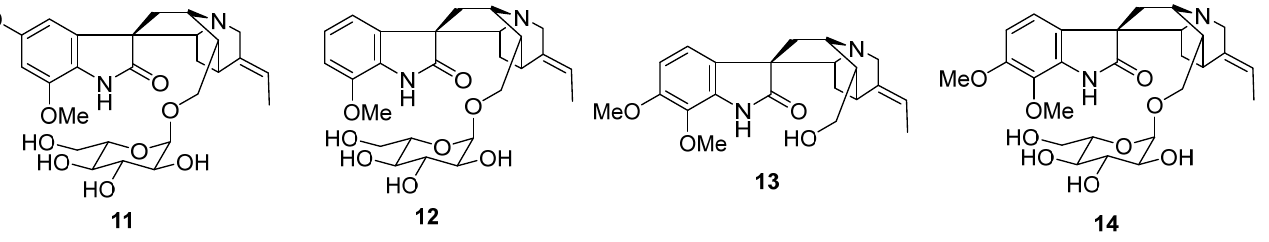
Figure 6. Monoterpenoid indoles 11 – 14 isolated from the leaves and stems of Gardneria multiflora .